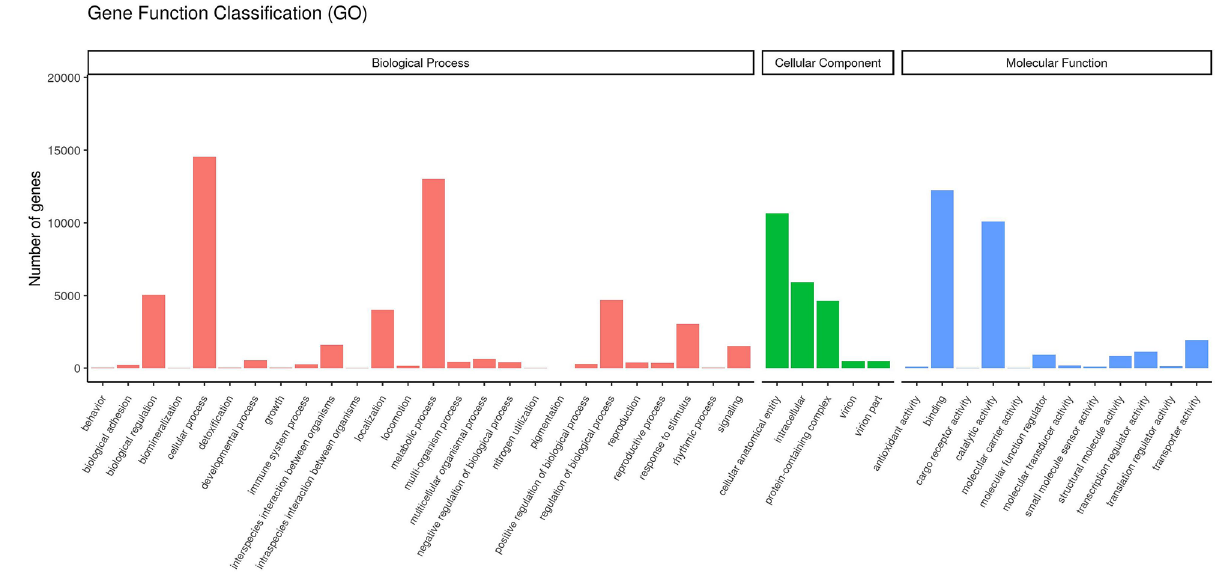
Figure 3. GO categories of the assembled unigenes. X-axis represents the GO terms names; Y-axis represents the number of unigenes: red pillars represent biological process, green pillars represent cellular process, and blue pillars represent molecular